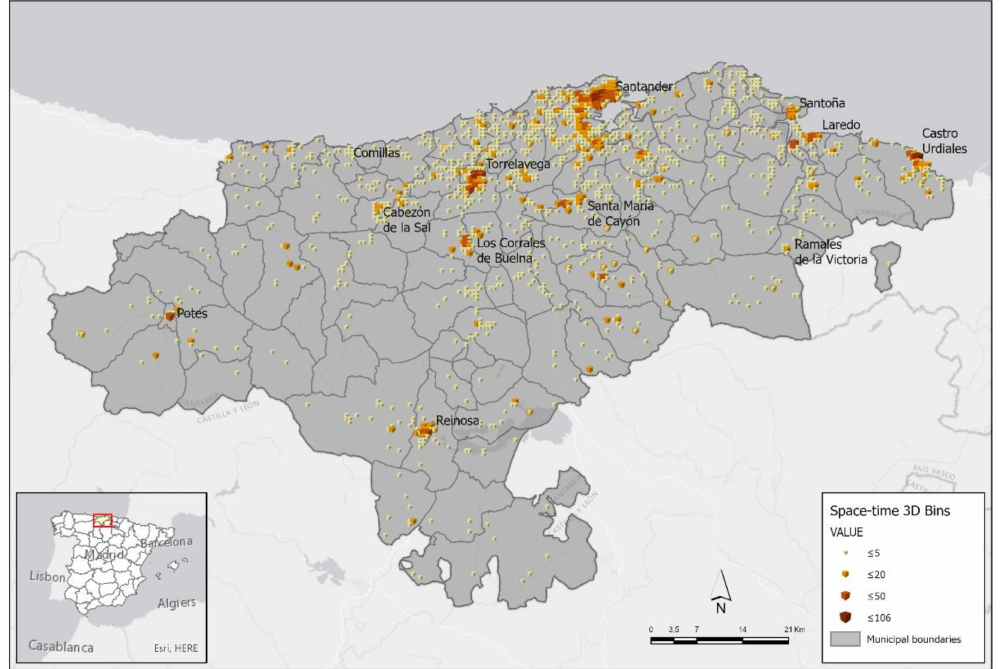
Figure 4. Space–time 3D bins of COVID-19 in the Autonomous Community of Cantabria (March–November 2020). Source: Own work based on COVID-19 microdata daily records from the health authorities (Government of Cantabria,